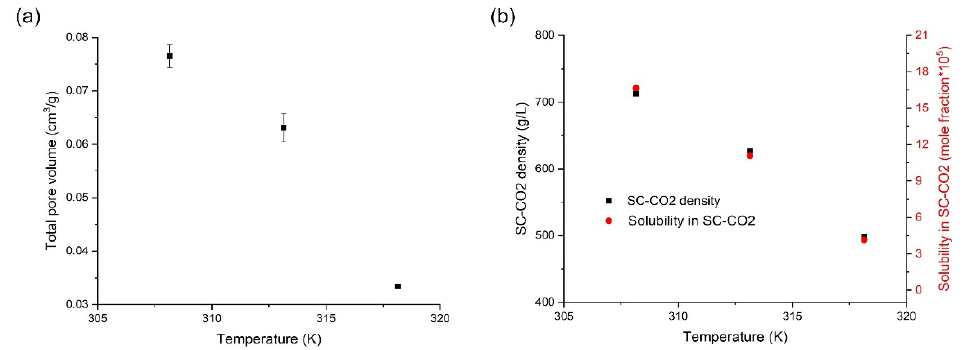
Figure 8. ( a ) Change in total pore volume with increasing temperature at 10 MPa and ( b ) the correlation of temperature with SC-CO 2 density and solubility of orlistat in SC-CO 2 .